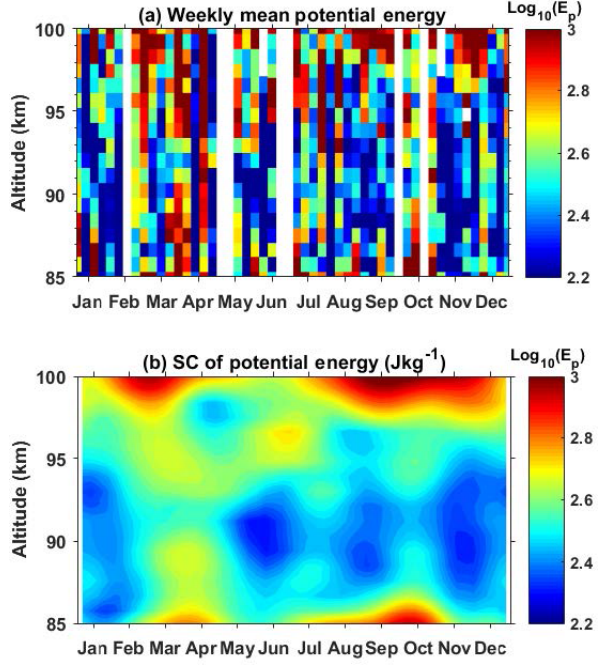
Figure 8. Same as Fig. 4 but for the